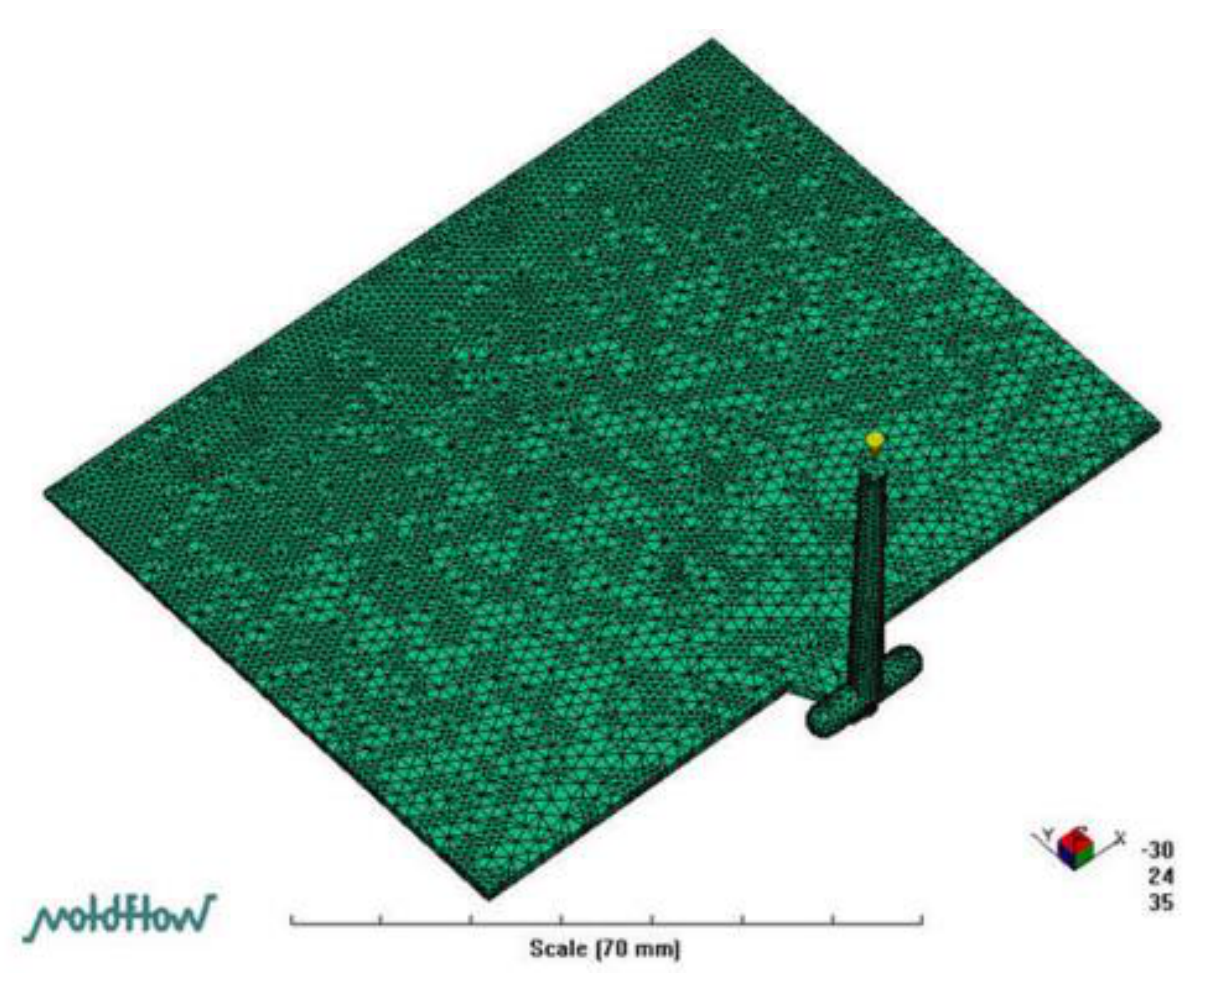
Figure 3. 3D-mesh on Moldflow analysis.